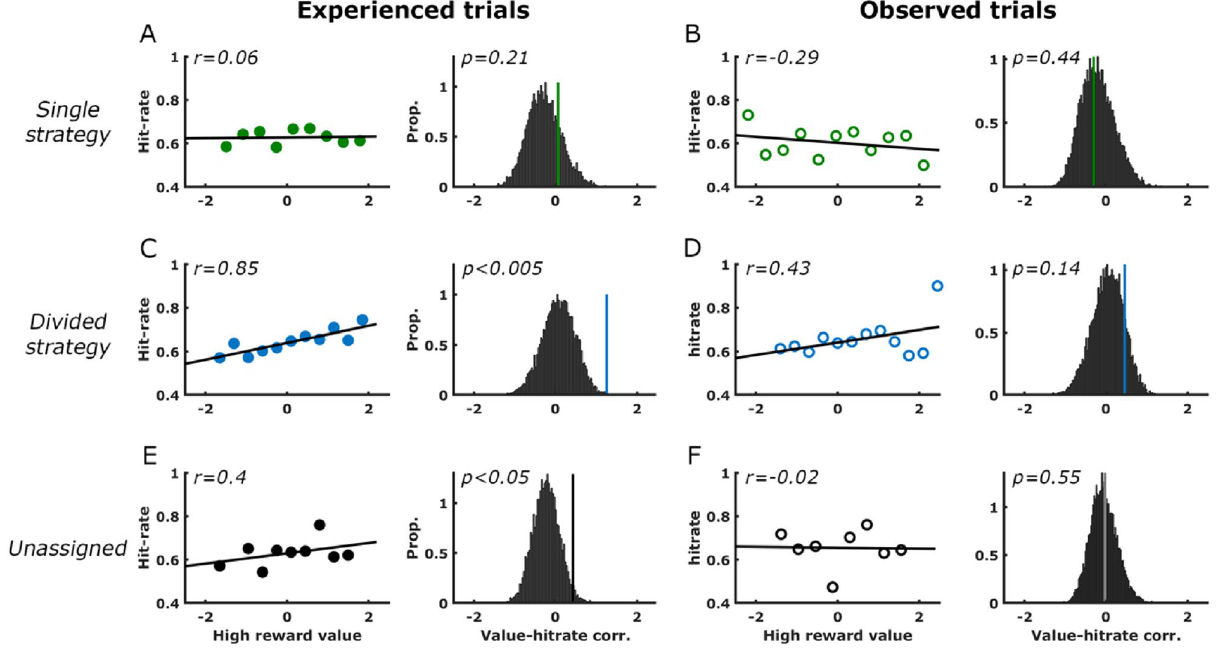
Figure 4. Memory performance is positively associated with maximum cue-values during experienced trials of the ‘divided strategy’ group. Scatter plots here and below depict correlations between memory performance (measured as proportion of hits) averaged across participants with the maximum stimulus-value available in a trial. ( A , C , E ). Correlations between memory performance and high reward values during experienced trials for the single-strategy, divided-strategy, and unassigned groups, respectively. All correlations were tested against 10,000 shuffles of each subject’s data (right panels). Actual correlations are represented by vertical lines in relation to the histogram of shuffled data. ( B , D , F ) Similar analysis as above for observed